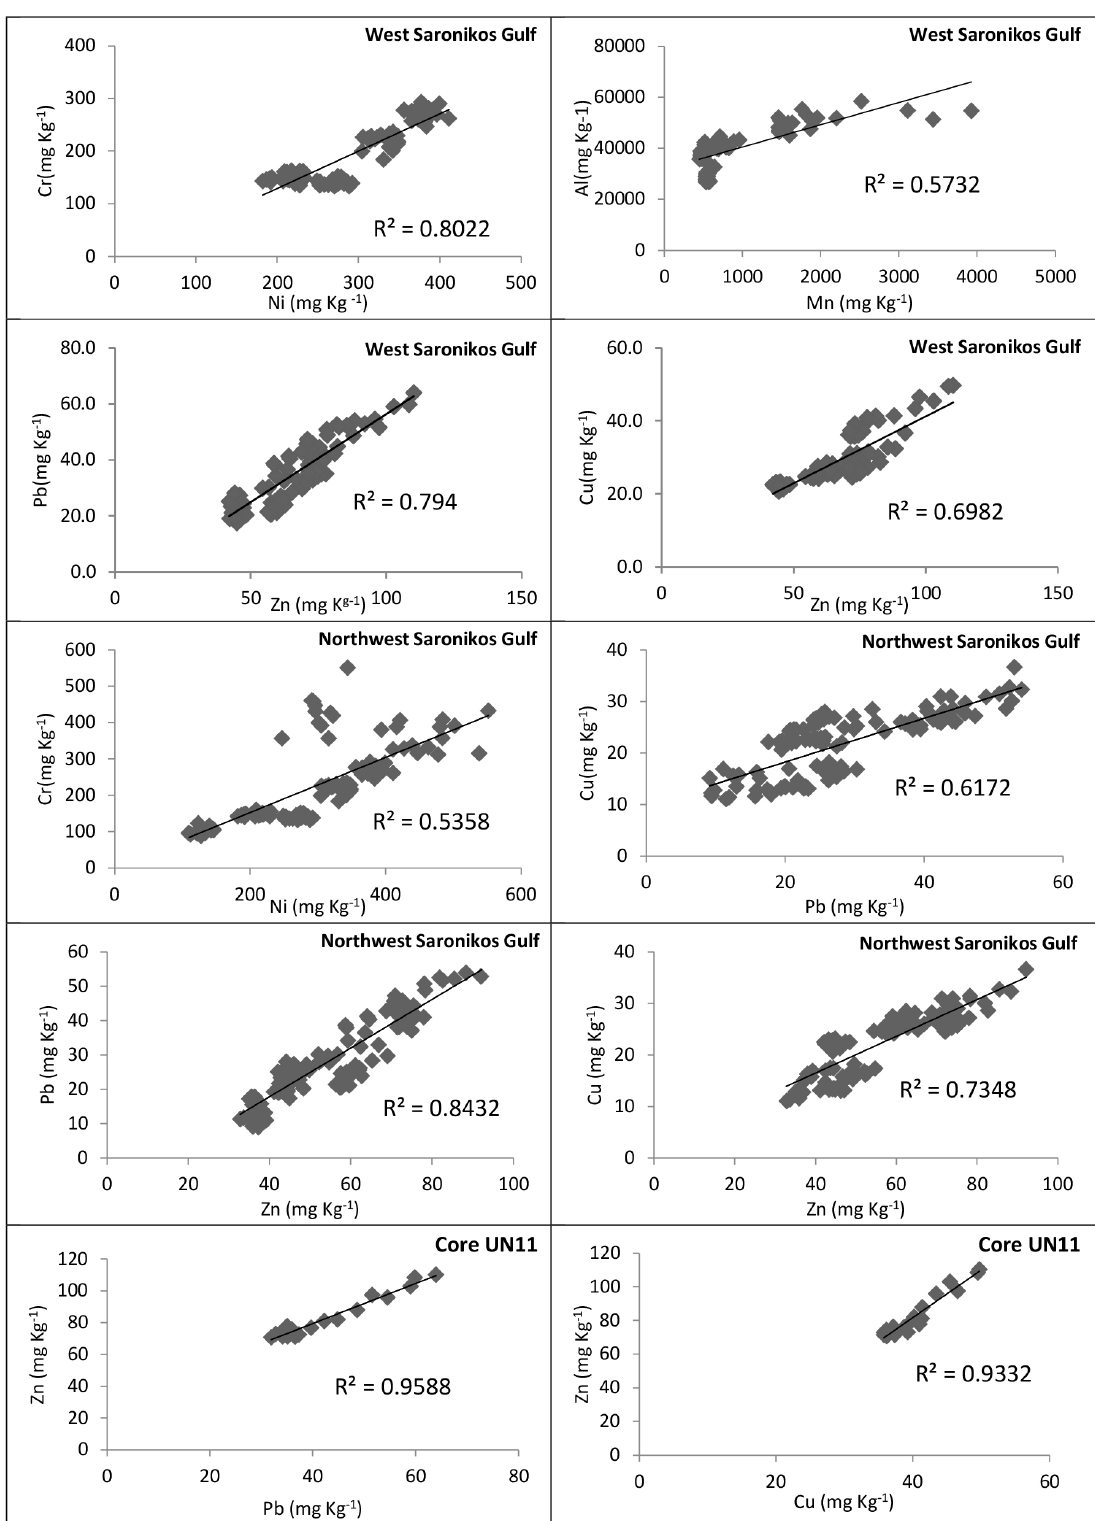
Figure A16. Correlations of heavy metals for the core samples of the western Saronikos